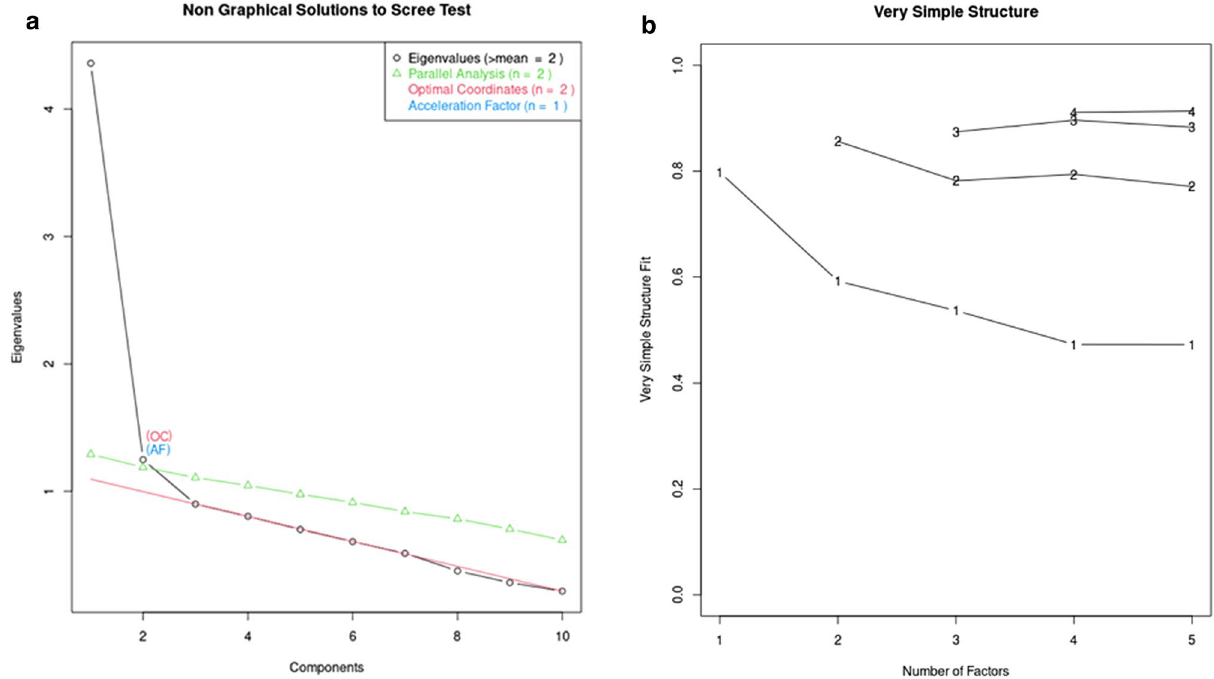
Figure 2. Left : Results of Parallel Analysis suggest that there are two factors contained in the 10 items that make the Flow Scale Short instrument. The green triangles represent random eigenvalues generated by the Parallel Analysis. The first two actually observed eigenvalues (black circles) were higher than the randomly generated eigenvalues (eigenvalue criterion). Right : VSS analysis suggest that the two-factor solution is optimal. Increasing factors beyond 2 results in increased BIC-values.